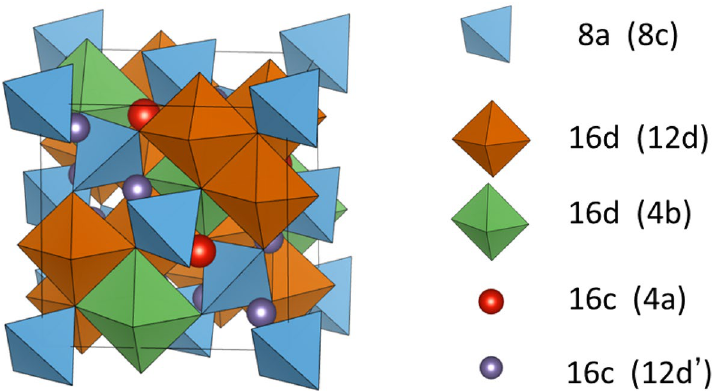
Figure 1. Schematic representation of the spinel-type crystal structure. Wyckoff positions of the sites occupied by cations and vacancies with maximum oxygen packing are described on the right. Wyckoff positions in the Fd 3 m and P 4 3 32 space groups are written without and with brackets, respectively.